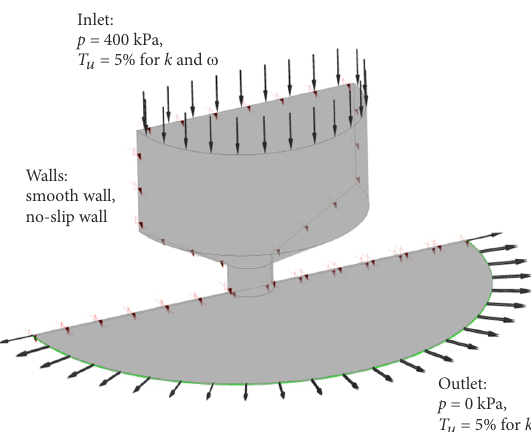
Figure 3. Airflow model limits